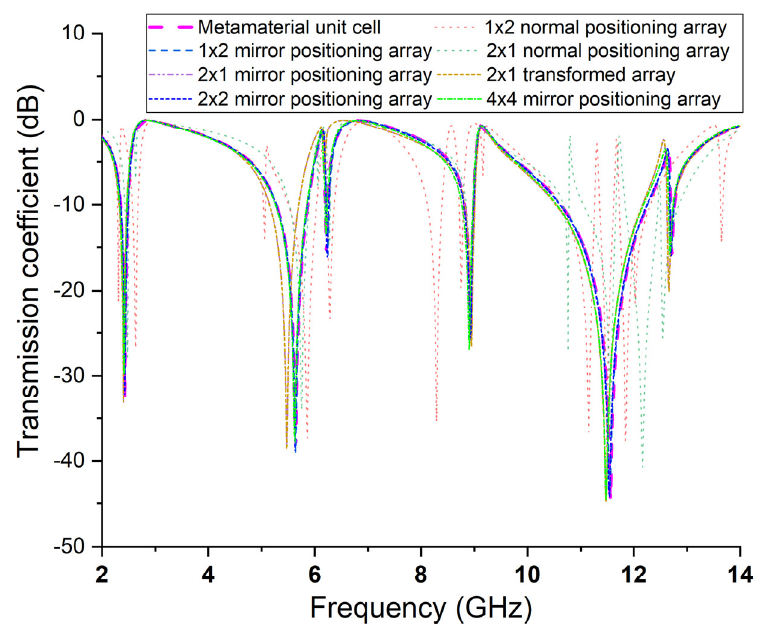
Figure 13. Transmission coefficient (S21) of differently sized metamaterial arrays with positioning.